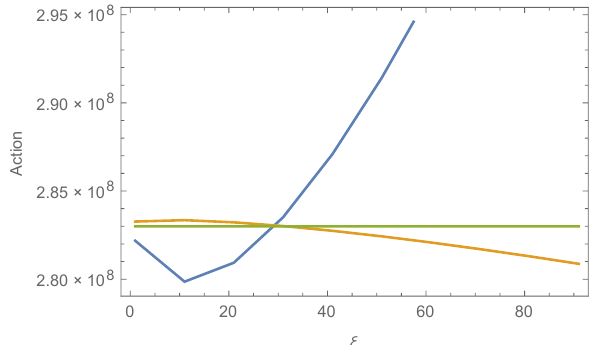
Figure 3. The gauge dependence of the effective action using the modifications proposed by the derivative expansion. The blue curve corresponds to the first modification. The orange curve corresponds to both the first two modifications. The green curve depicts the action incorporating all three modifications proposed in